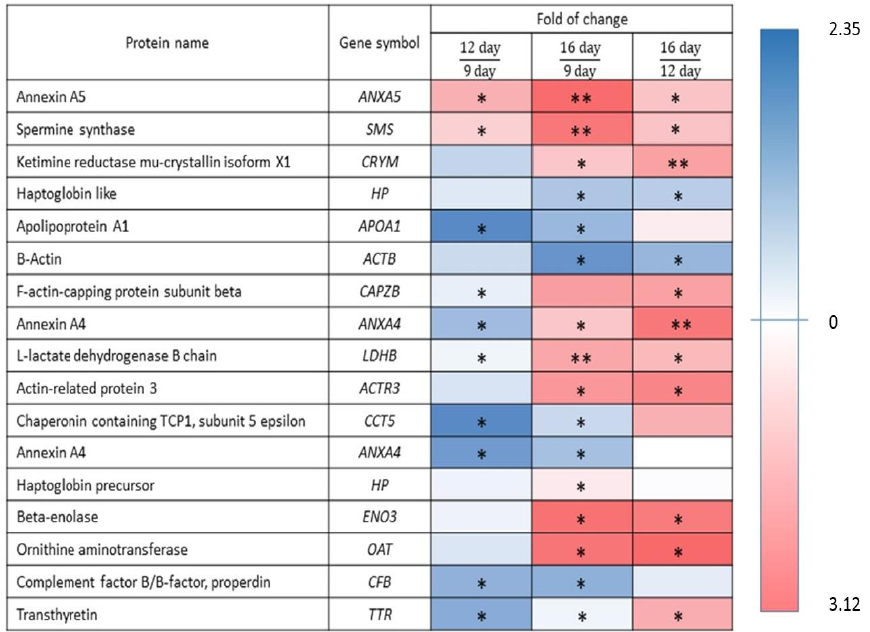
Figure 3. Effects of the fold of change (FC) observed in the DEPs of endometrial tissue during 9D, 12D and 16D of pregnancy. *— p < 0.05; **— p < 0.01; (Fold change marked in blue colour indicate upregulated ( ↑ )DEPs and fold change marked in red colour indicated downregulated ( ↓